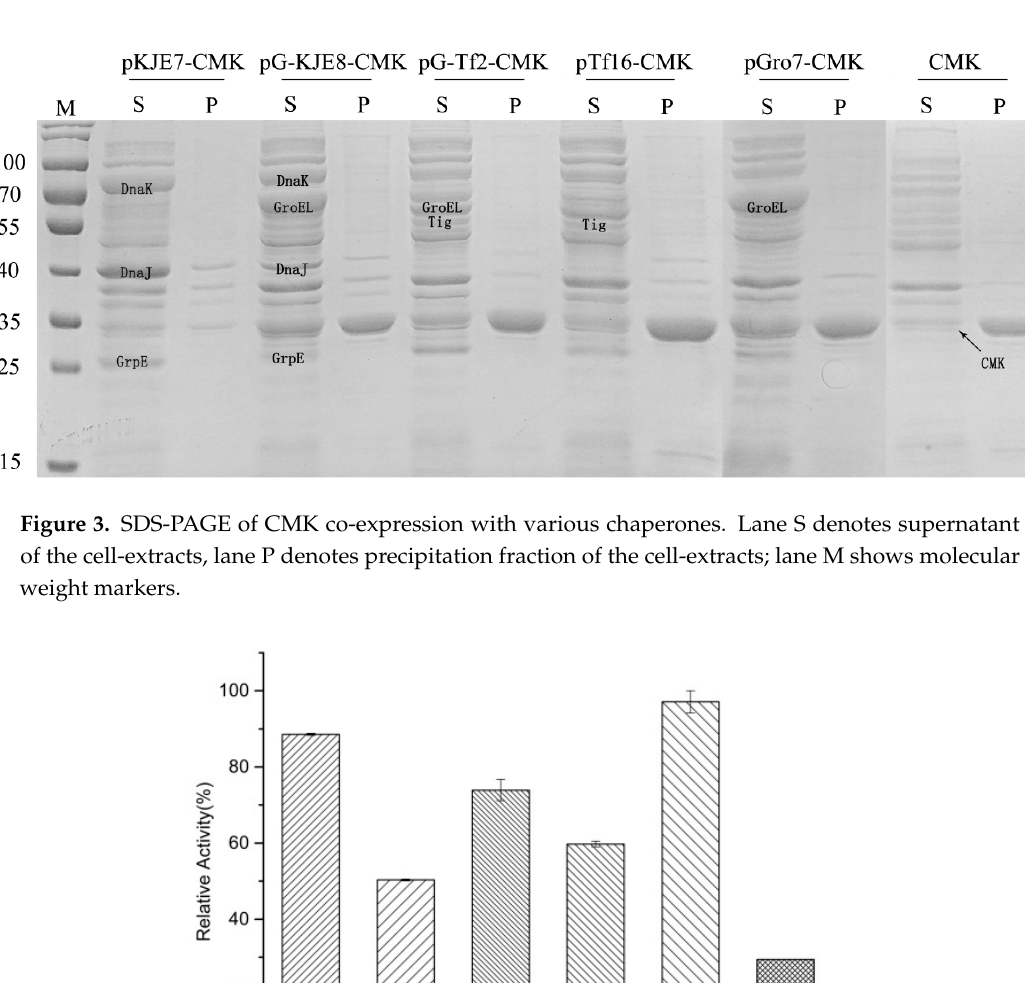
Figure 3. SDS-PAGE of CMK co-expression with various chaperones. Lane S denotes supernatant of the cell-extracts, lane P denotes precipitation fraction of the cell-extracts; lane M shows molecular weight markers.